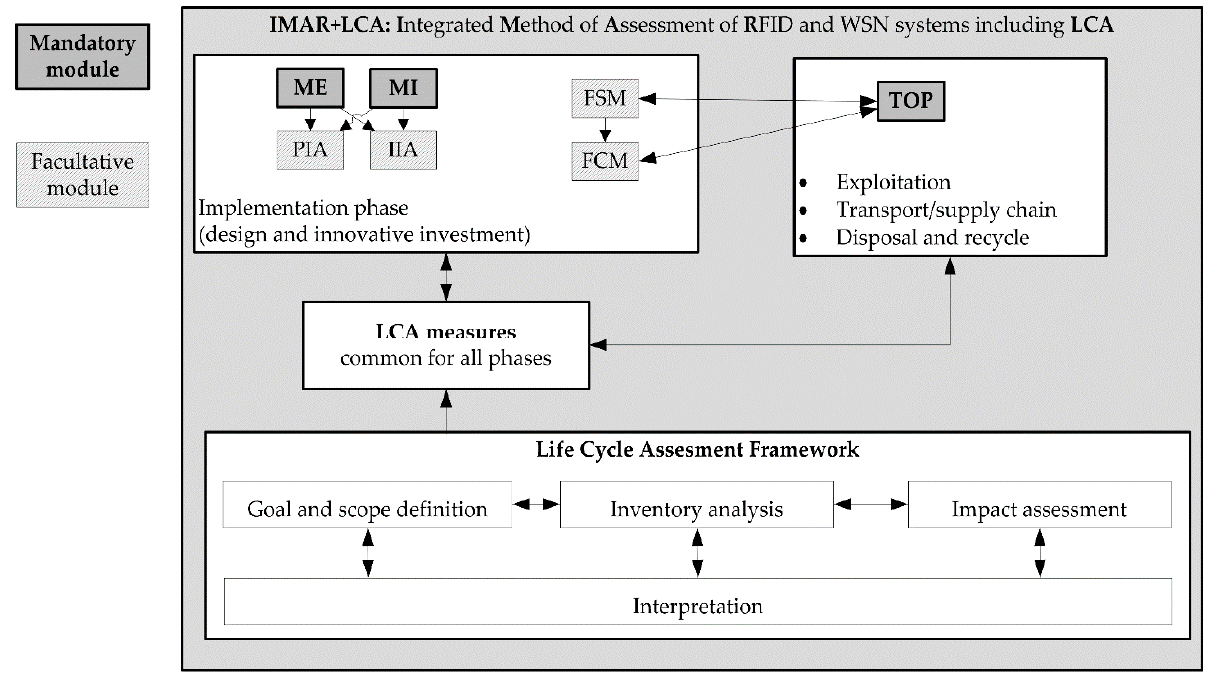
Figure 3. IMAR extended to IMAR+LCA.